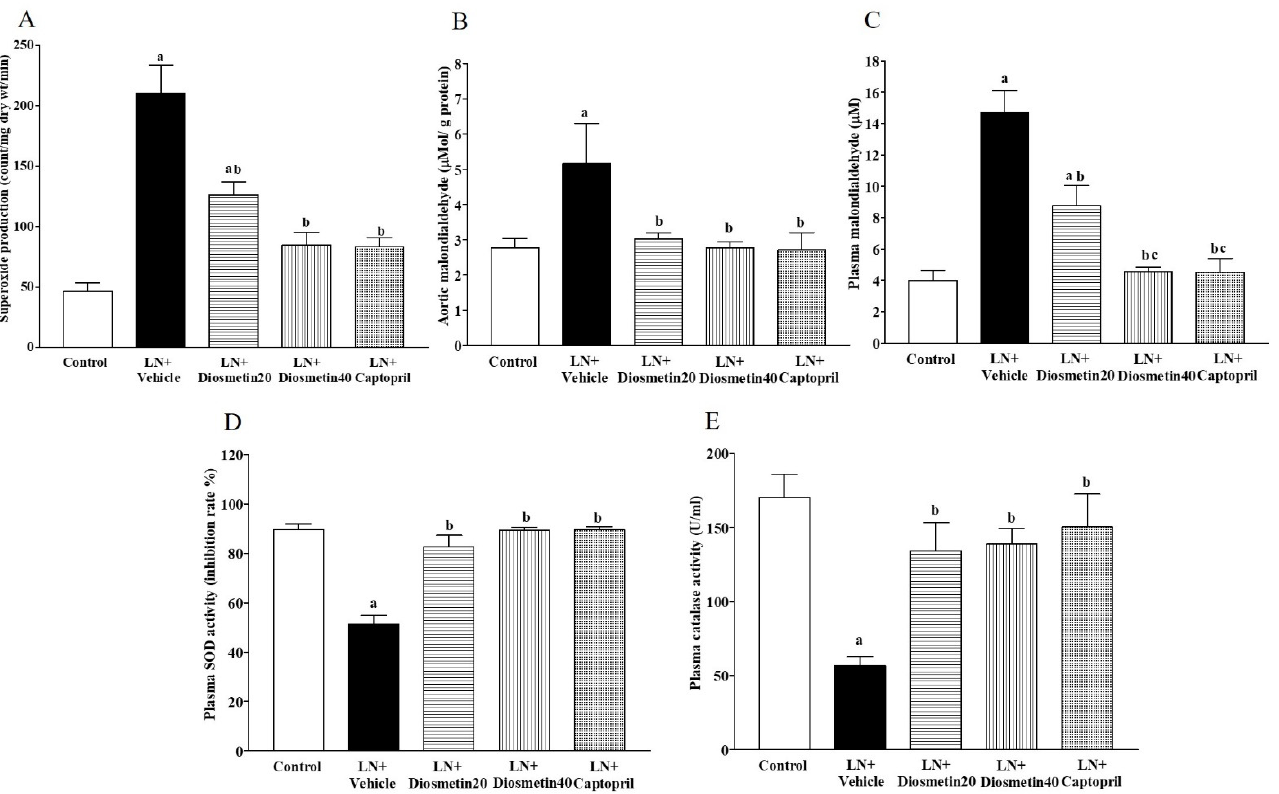
Figure 4. Effect of diosmetin and captopril on vascular O 2• − production ( A ), aortic MDA levels ( B ), plasma MDA levels ( C ), plasma SOD activity ( D ), and plasma CAT activity ( E ) in LN-induced hypertensive rats. a p < 0.05 vs. control group, b p < 0.05 vs. LN + vehicle group, c p < 0.05 vs. LN + diosmetin20 group. LN, L-NAME; LN + diosmetin20, L-NAME treated with 20 mg/kg of diosmetin; LN + diosmetin40, L-NAME treated with 40 mg/kg diosmetin; LN + captopril, L-NAME